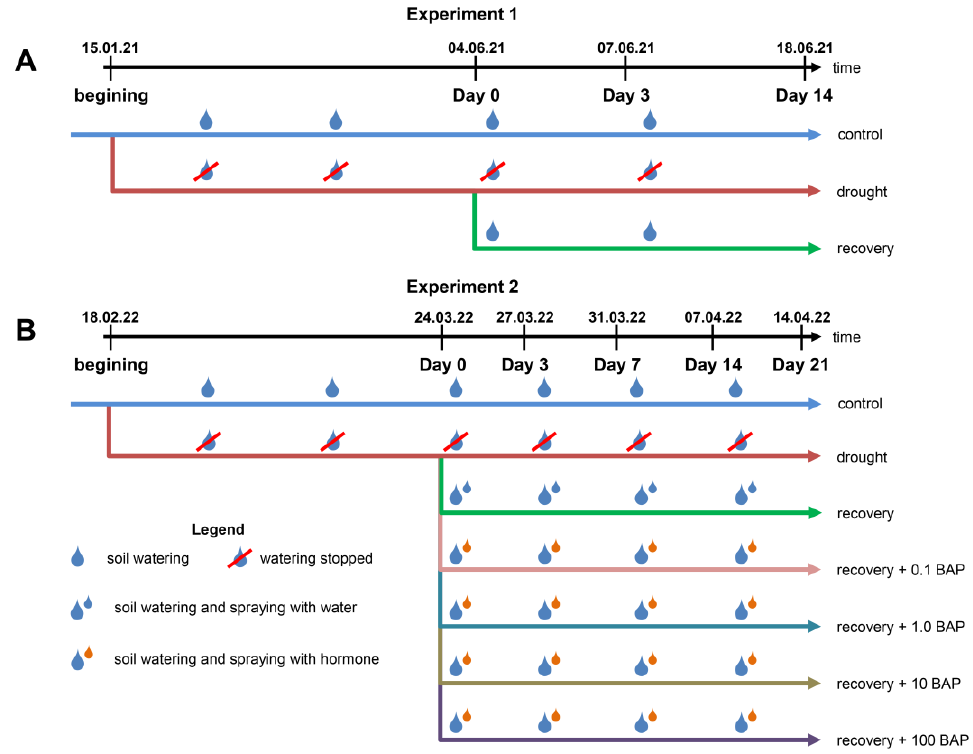
Figure 1. The design of Experiment 1 ( A ) and Experiment 2 ( B ). The scheme design of Experiment 1 was adapted from Zlobin et al. [14]. BAP — 6-benzylaminopurine.